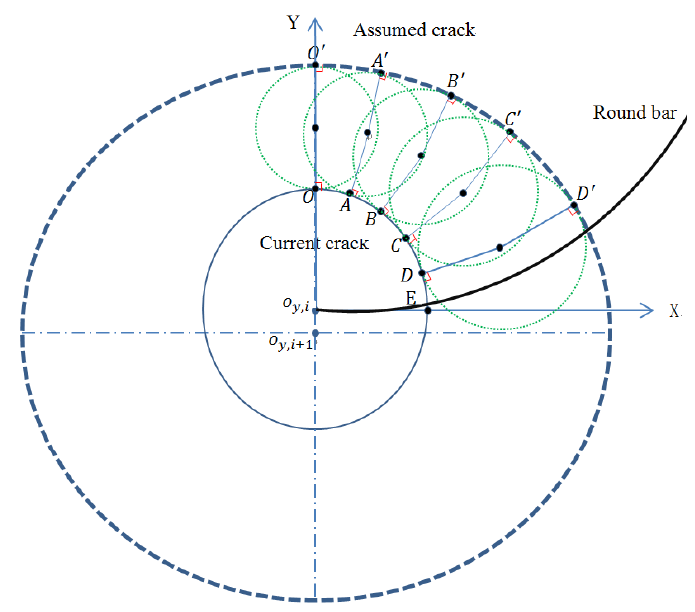
Figure 2. Determination of a new crack front by fatigue crack growth circles.